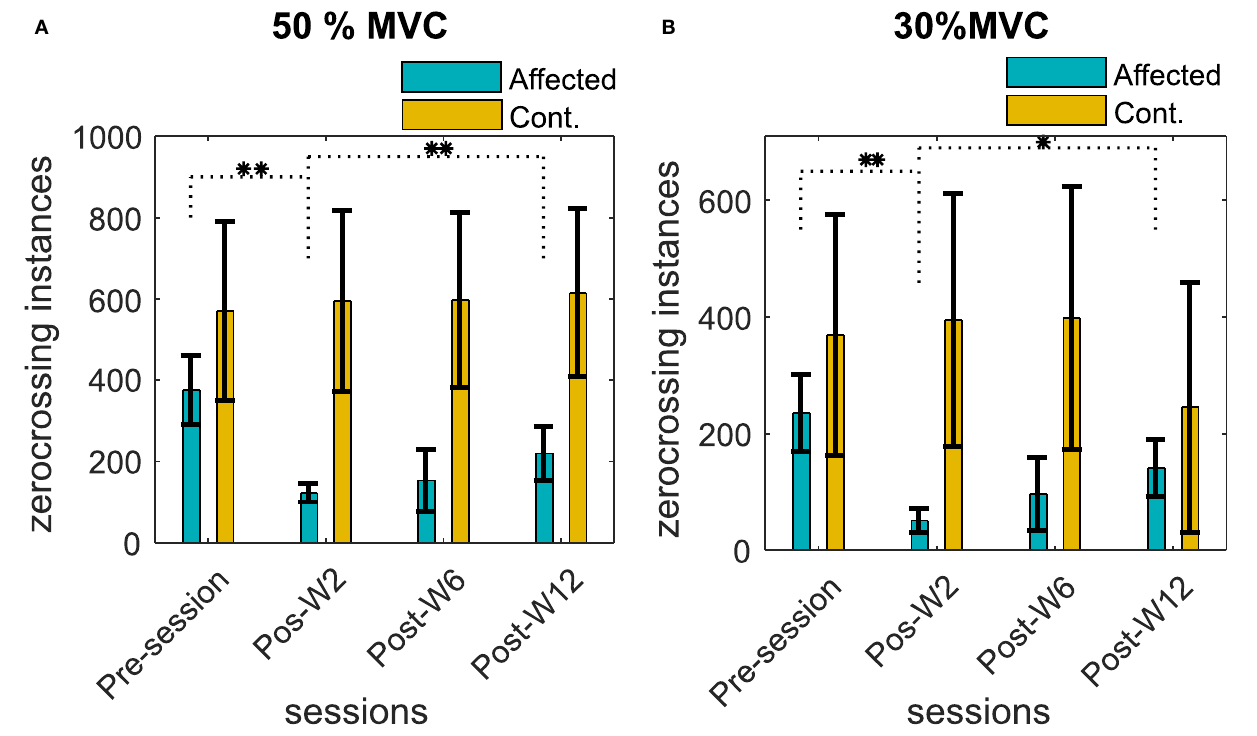
FIGURE 7 | Number of ZCs in the sEMG signal during (A) 50% MVC and (B) 30% MVC contraction level across the recording sessions. The column height represents the mean, while the error bar represents the standard deviation of the ZC values at the session for the subjects. Statistically significant difference of the EMD values ( p < 0.05/ p < 0.01) in the affected side across sessions is indicated by